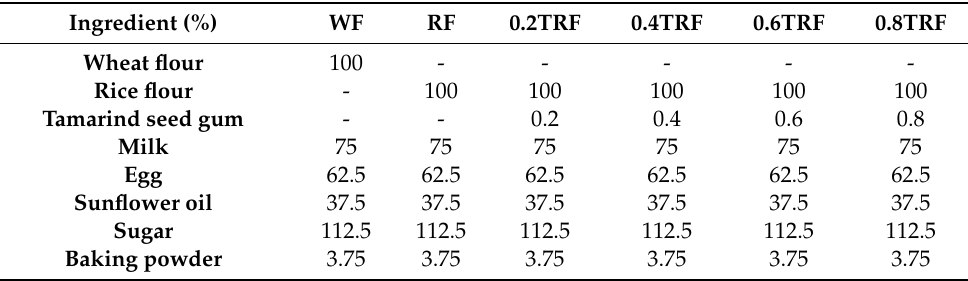
Table 1. Formulation of cake and gluten-free